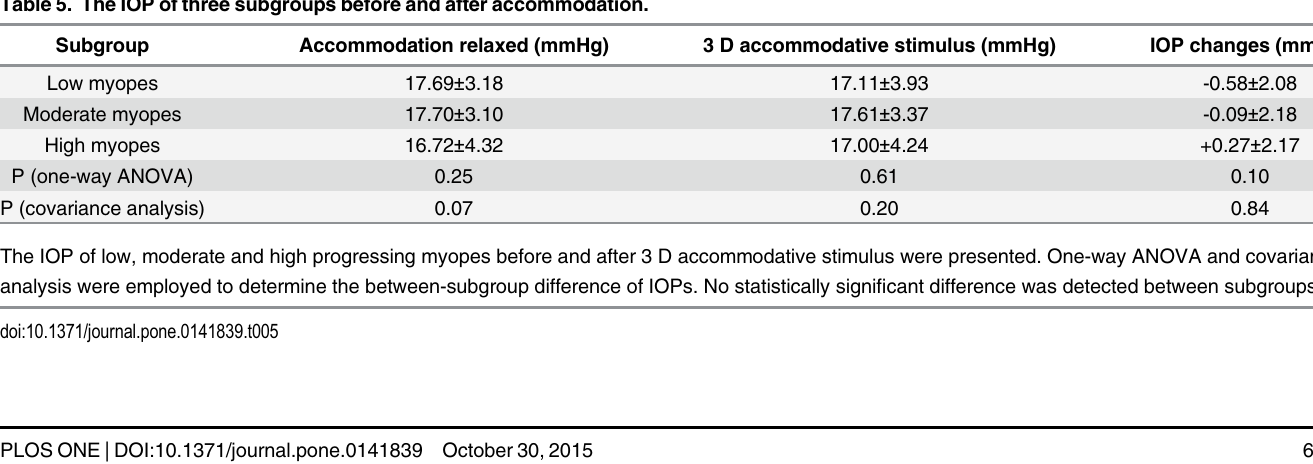
Table 5. The IOP of three subgroups before and after accommodation.